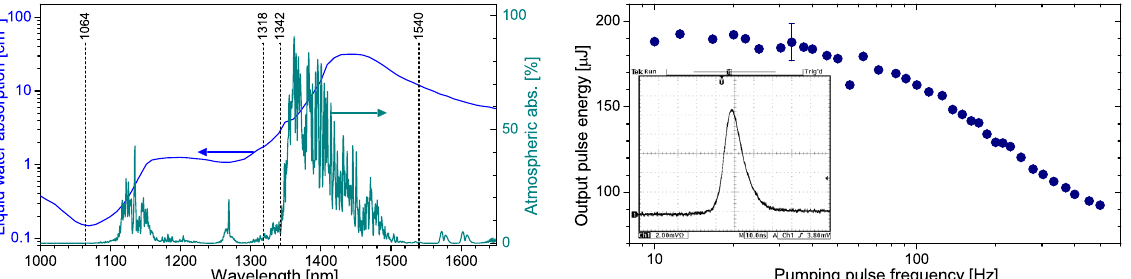
Fig. 1. Liquid water and atmospheric absorption spectra.